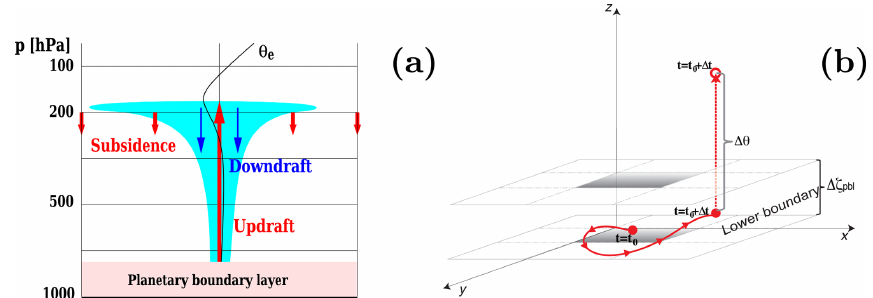
Figure 4. (a) Schematic definition of convective fluxes and scales. Vertically unstable profile of the equivalent potential temperature θ e (black thin line) triggers convective updraft in our simplified scheme. (b) Convective updraft in CLaMS: the original trajectory (thick solid red) and the modified trajectory (dashed red) with convective transport from the lowest CLaMS layer (cid:49)ζ pbl at time step t 0 + (cid:49)t . The vertical displacement (cid:49)θ of the considered air parcel is estimated through the latent heat release of condensation and may happen at every time step along the trajectory when the reanalysis data are read (i.e., every (cid:49)t = 6h for ERA-Interim, see text for more